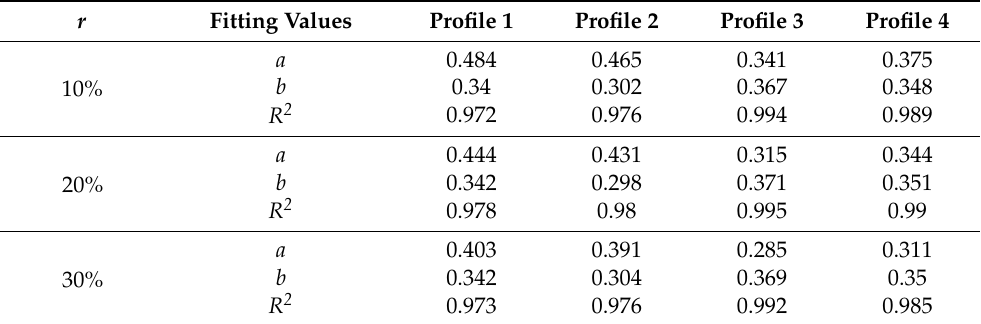
Table 4. Fitting result of coated insulator under four different coating damage profile and r